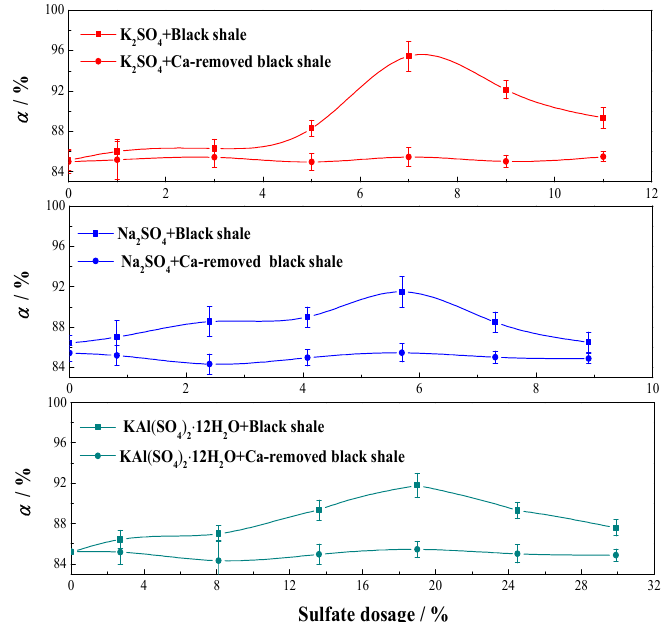
Figure 2. Variation of vanadium leaching efficiency as a function of the three sulfate dosages with leaching temperature of 150 °C, leaching time of 5 h and acid concentration of 4 M.